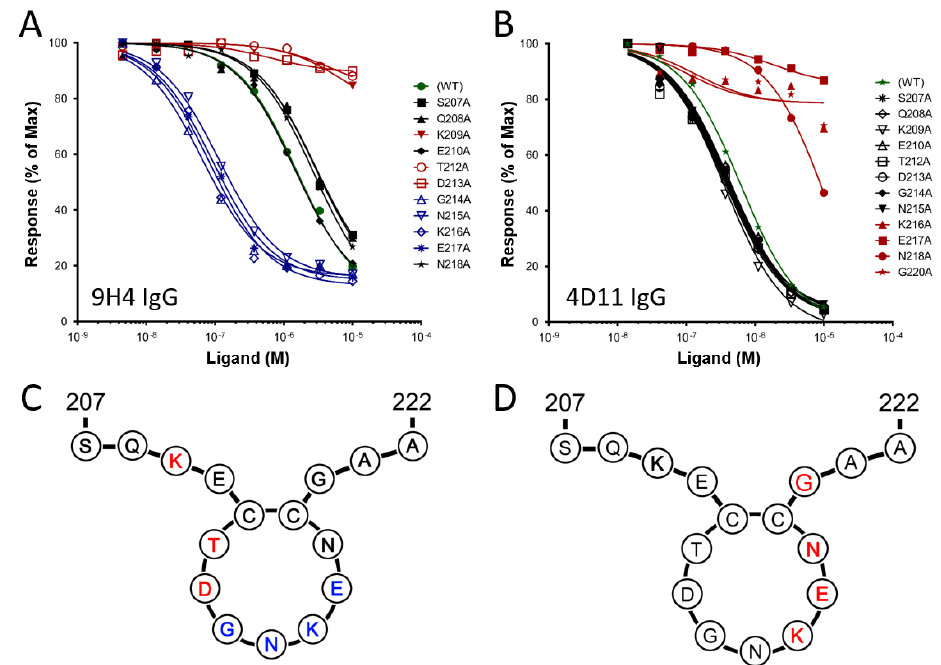
Figure 1. SPR competition assay using alanine-scan 16-residue peptides of 3D7-MSP2 207–222 with ( A ) mAb 9H4 and ( B ) mAb 4D11. Schematic representation of disulfide-bonded epitope sequence for both ( C ) 9H4 and ( D ) 4D11 indicating the location of key residues. Black indicates alanine mutants with no effect on binding, the green shows the wild-type binding of 3D7-MSP2 207–222 , red indicates the alanine mutations that decreased the binding and blue indicates mutations that increased binding. Table 1. Alanine scan of 16-residue epitope MSP2 207–222 to determine key residues for binding of mAbs 9H4 and 4D11. The Ala residue is highlighted in red. Peptide Sequence